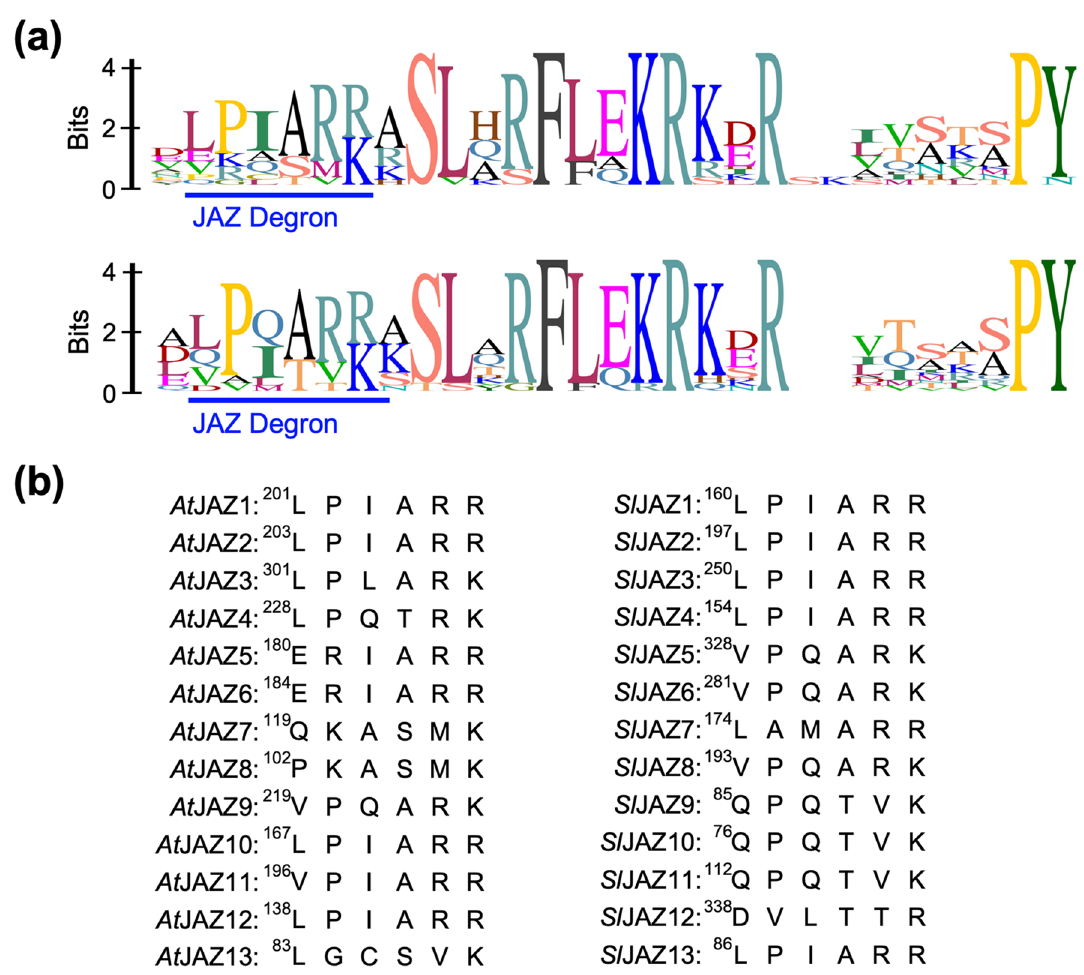
Figure 1. ( a ) Sequence logos of the Jas motif of At JAZs (top) or Sl JAZs (bottom). Sequence logos were created by Geneious 2019.2.1 software (TOMY DIGITAL BIOLOGY CO.,LTD., Japan). ( b ) Canonical JAZ degron sequences of At JAZs (left) and Sl JAZs